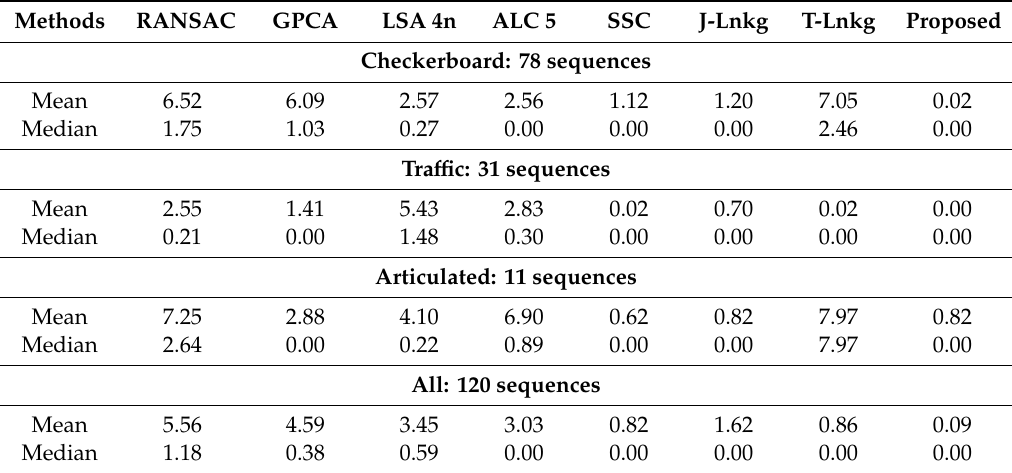
Table 2. Classification errors (%) for sequences with two